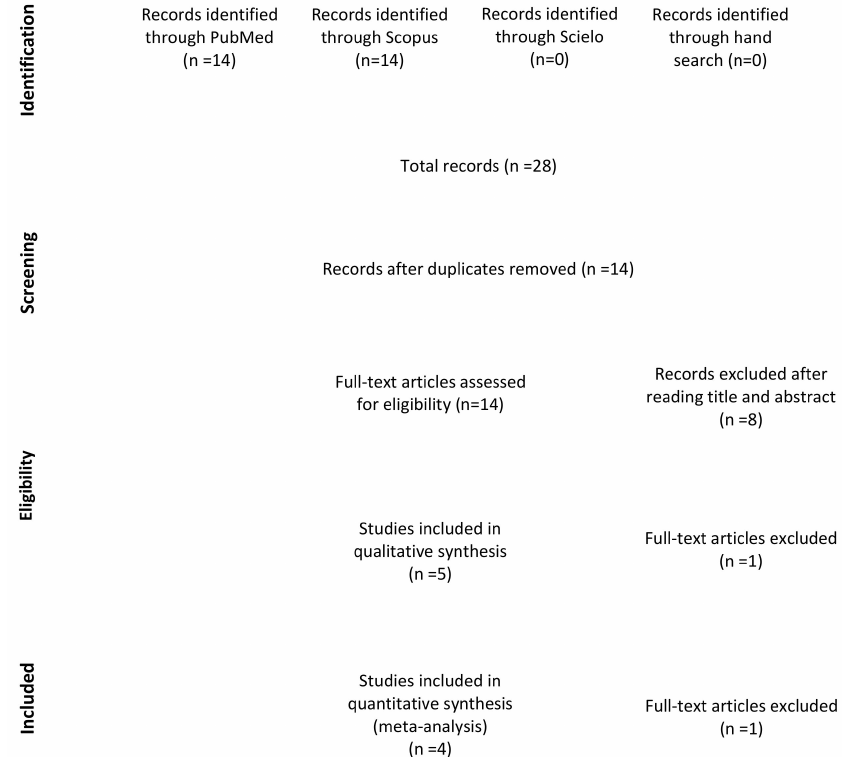
Figure 1. Preferred Reporting Items for Systematic Reviews and Meta-Analyses (PRISMA) flow diagram of selection